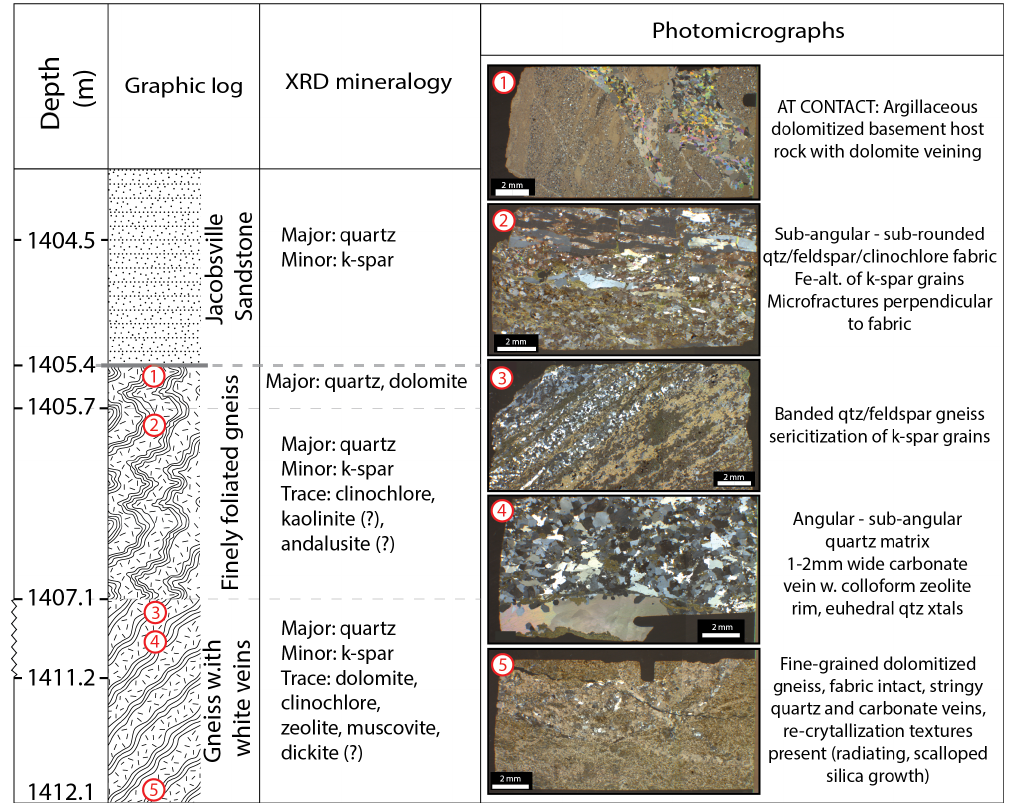
Figure 10. Petrographic summary, depth in meters measured, photomicrographs, and X-ray diffraction results of nonconformity units studied in the CPC BD-139 core. (a) The basement sample at the contact is an argillaceous dolomitized gneiss with dolomite veins (XPL); (b) folia- tion defined by quartz–feldspar–clinochlore fabric with iron alteration of potassium feldspar grains (XPL); (c) banded quartz–feldspar gneiss with common sericitization of potassium feldspar grains (XPL); (d) carbonate vein with colloform zeolite rim and euhedral quartz crystals (XPL); (e) dolomitized gneiss with common quartz and carbonate veins